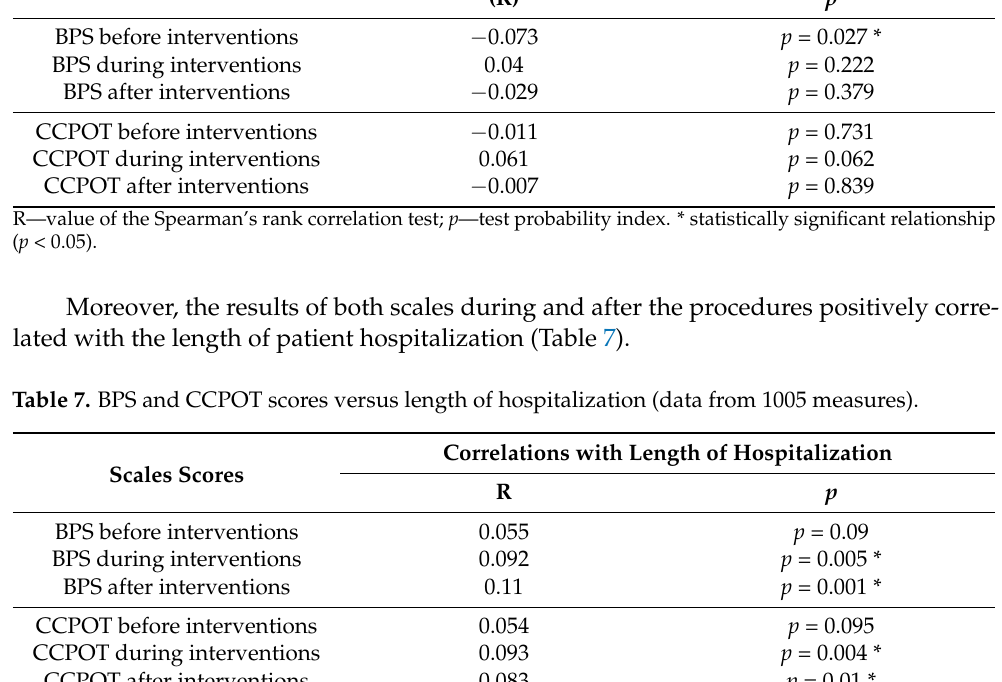
Table 6. Correlations between patients’ age and BPS, CCPOT scores (data from 1005 measurements). Correlations with Age Scales Scores (R) p − 0.073 p = 0.027 *